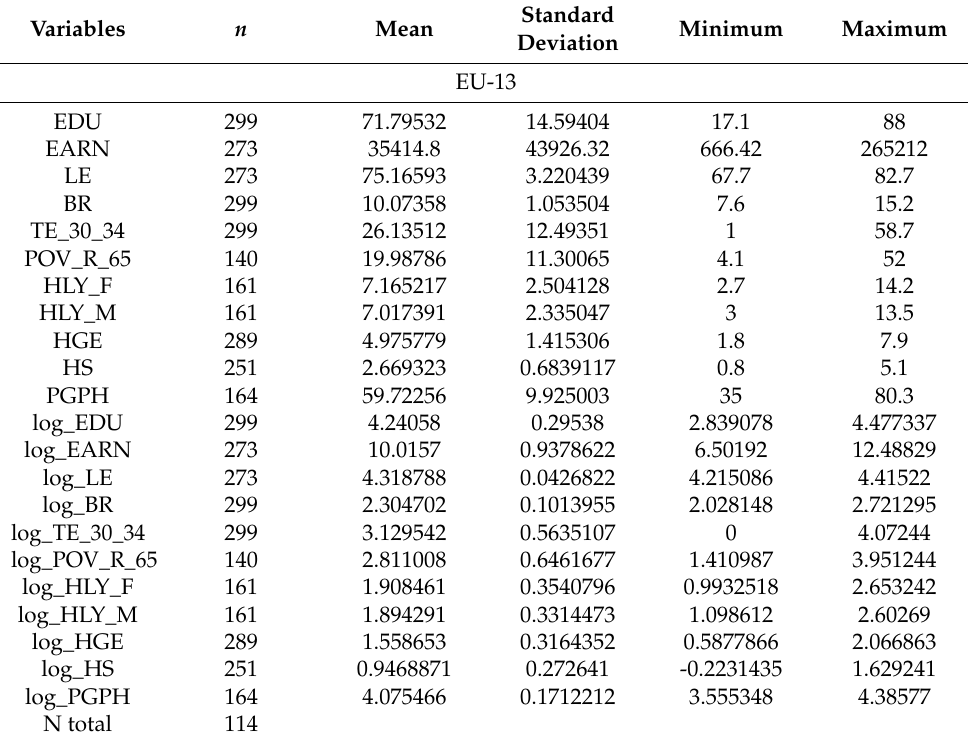
Table A1. Summary statistics for the EU-13 and EU-15 datasets,